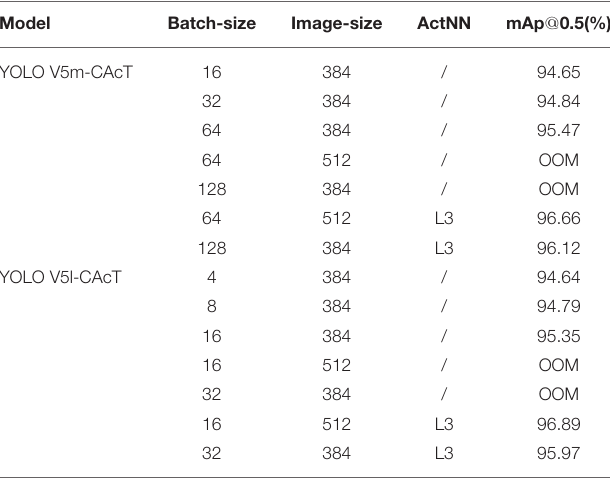
TABLE 10 | ActNN compression test results at the L3 level.